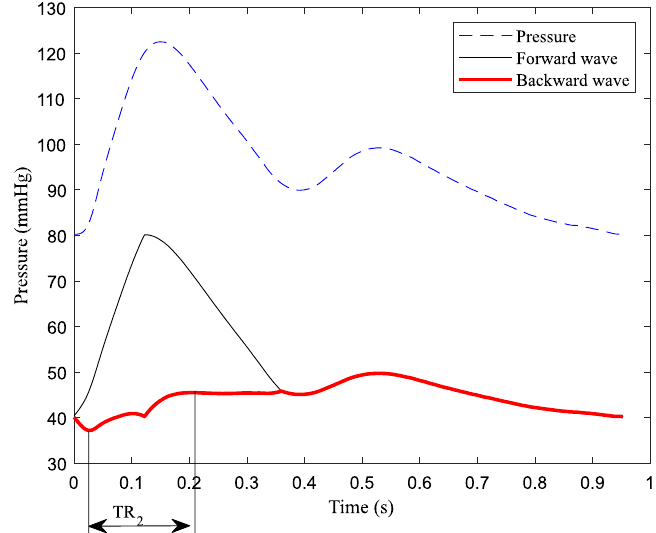
Figure 4. The time difference between forward wave and backward wave of aortic pressure wave.